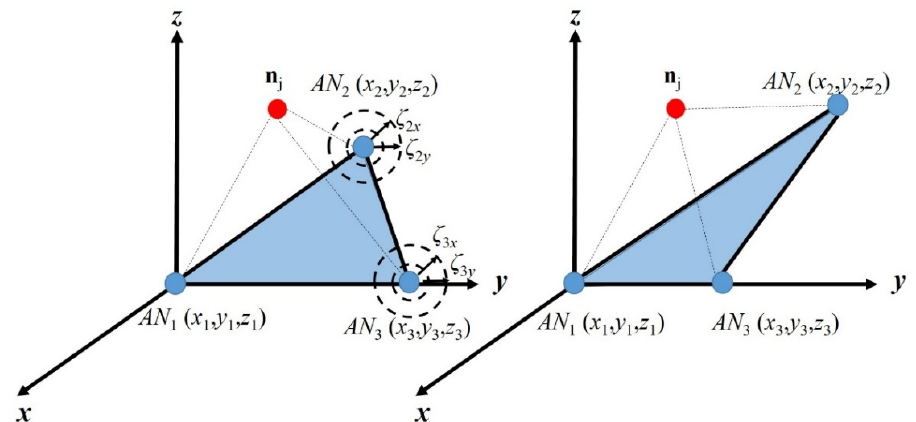
13 of 16 Figure 8. Performance improvement analysis of the RL algorithm for different r max .